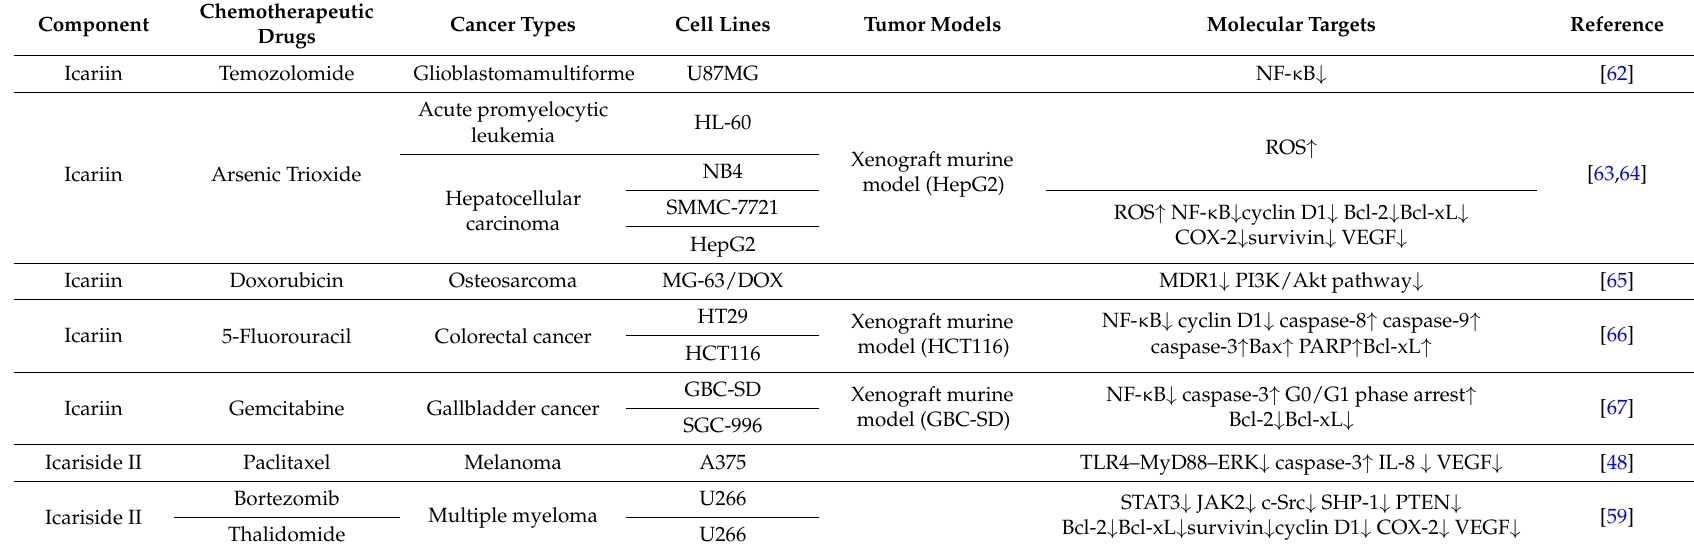
Table 3. Icariin and icariside II used as adjuvant agents in combination with hemotherapeutic